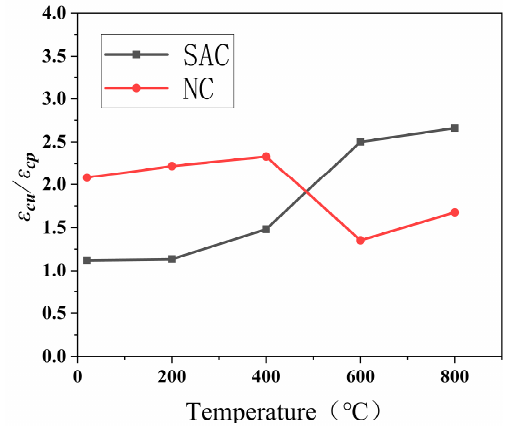
Figure 12. Effect of temperature on ε cu / ε cp.